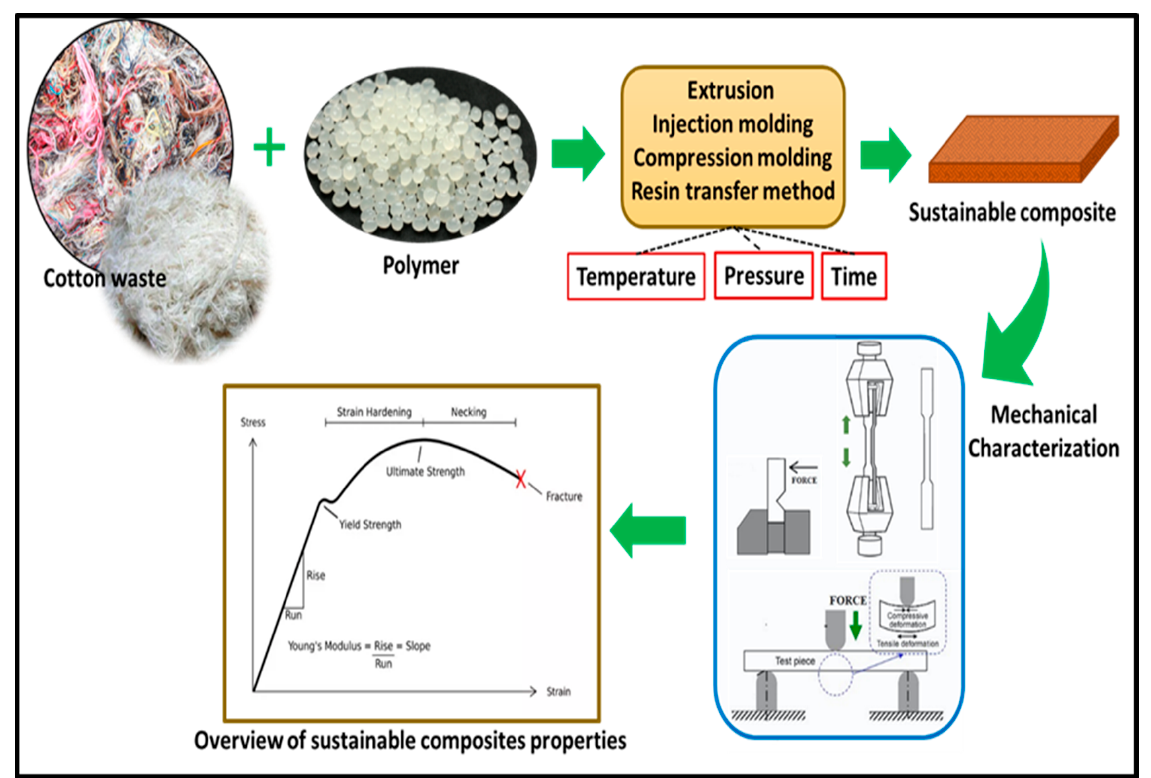
Figure 3. Sustainable composite properties for effective application [69].